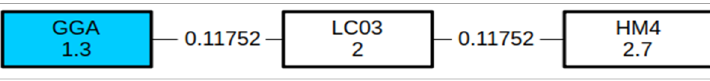
- Figure 12. p -values graph of the compared methods. Finally, the Friedman statistics computed by analyzing the results produced by these three methods with 10 problems is 9.8, and the corresponding p -value is 0.007447, therefore the null hypothesis is rejected. The Bermann–Hommel post-hoc test is then applied to find all possible hypotheses that cannot be refused. Table 9 shows the results of these tests, and Figure 13 shows the graph corresponding to these p -values. Table 9. p -values for multiple comparisons among methods. Method AR GGA p -Values Unadjusted Bergmann–Hommel LC03